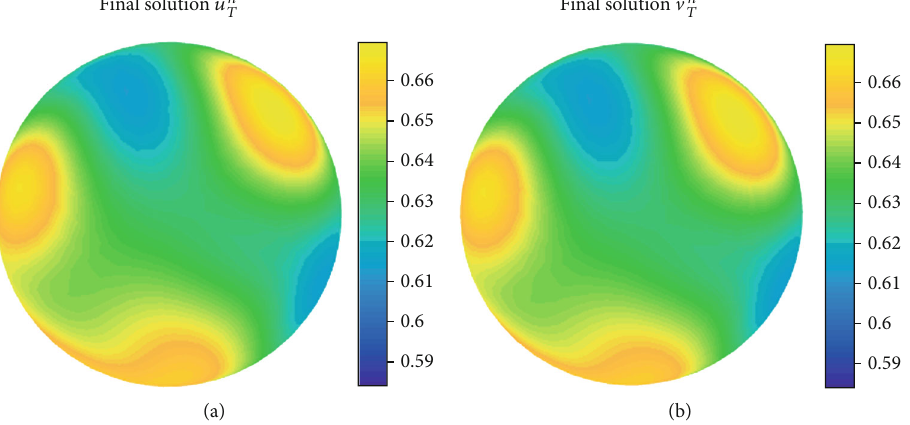
= 0 : 0005 , D = 0 : 025 , T = 100 , and k = 0 : 35 u v